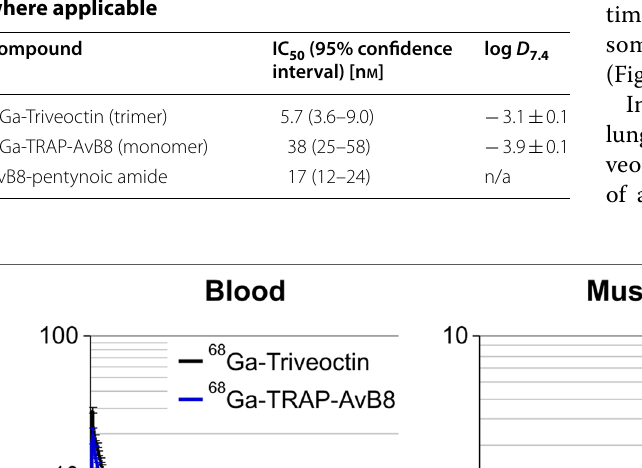
1 MBq, 64 13 pmol, 182 30 MBq/nmol) and 68 Ga-TRAP-AvB8 (blue; 11 ± ± ±